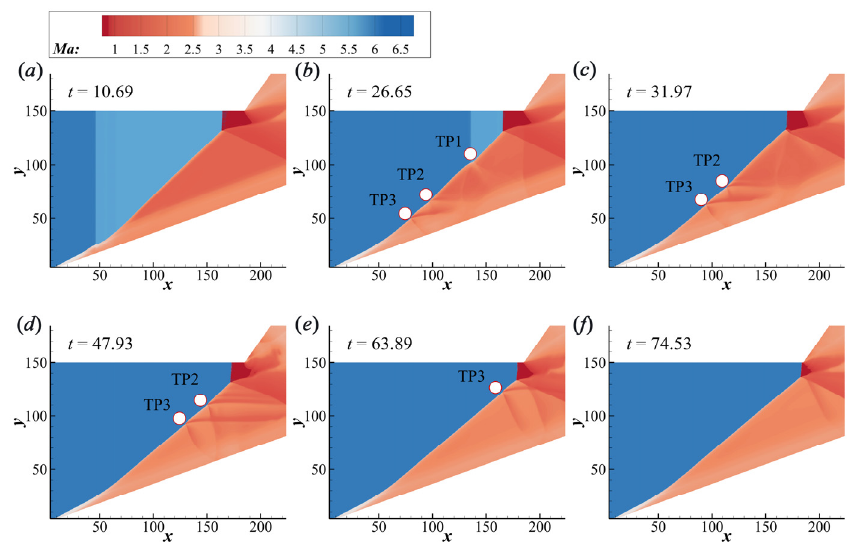
Figure 5. Mach number contours of ODW at different instants when M 0 increases from 5.5 to 6.0. ( a ) t = 10.69, ( b ) t = 26.65, ( c ) t = 31.97, ( d ) t = 47.93, ( e ) t = 63.89, and ( f ) t = 74.53.